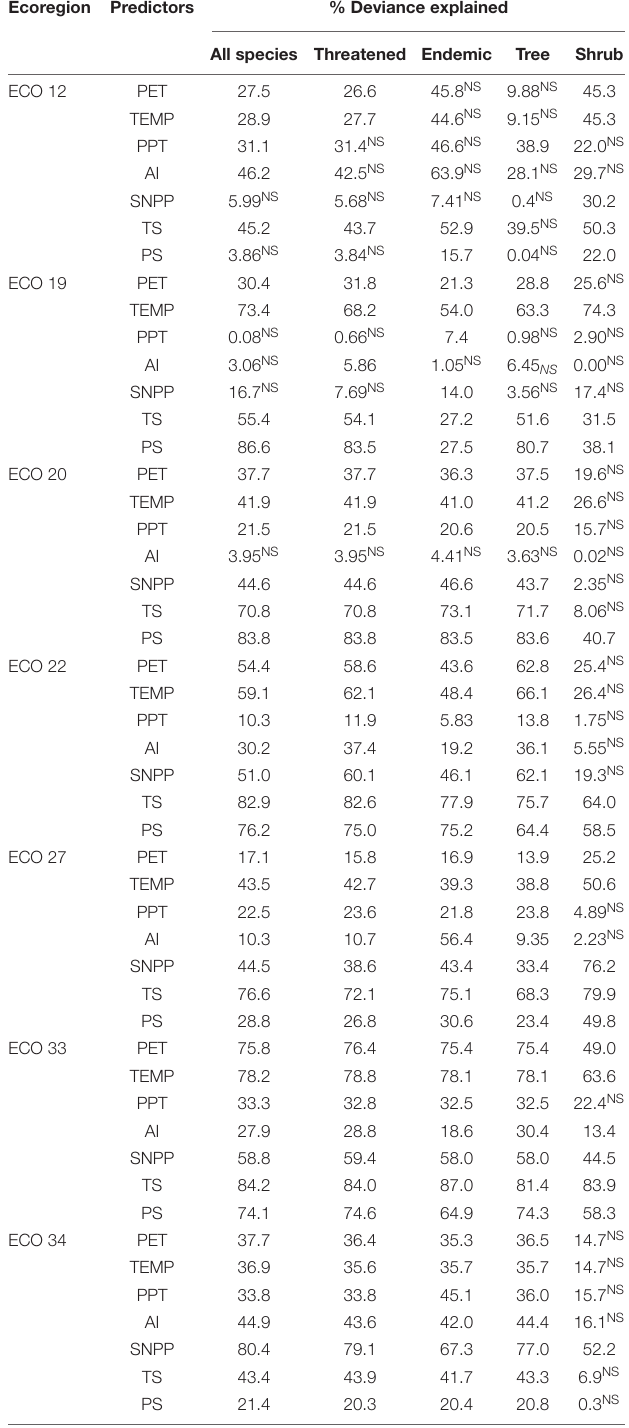
TABLE 1 | Percentage of deviance explained by individual predictors for the species richness patterns of all gymnosperm species, threatened, endemic, tree, and shrub in ecoregions of China evaluated by the generalized additive model (GAM). Ecoregion Predictors % Deviance explained All species Threatened Endemic Tree